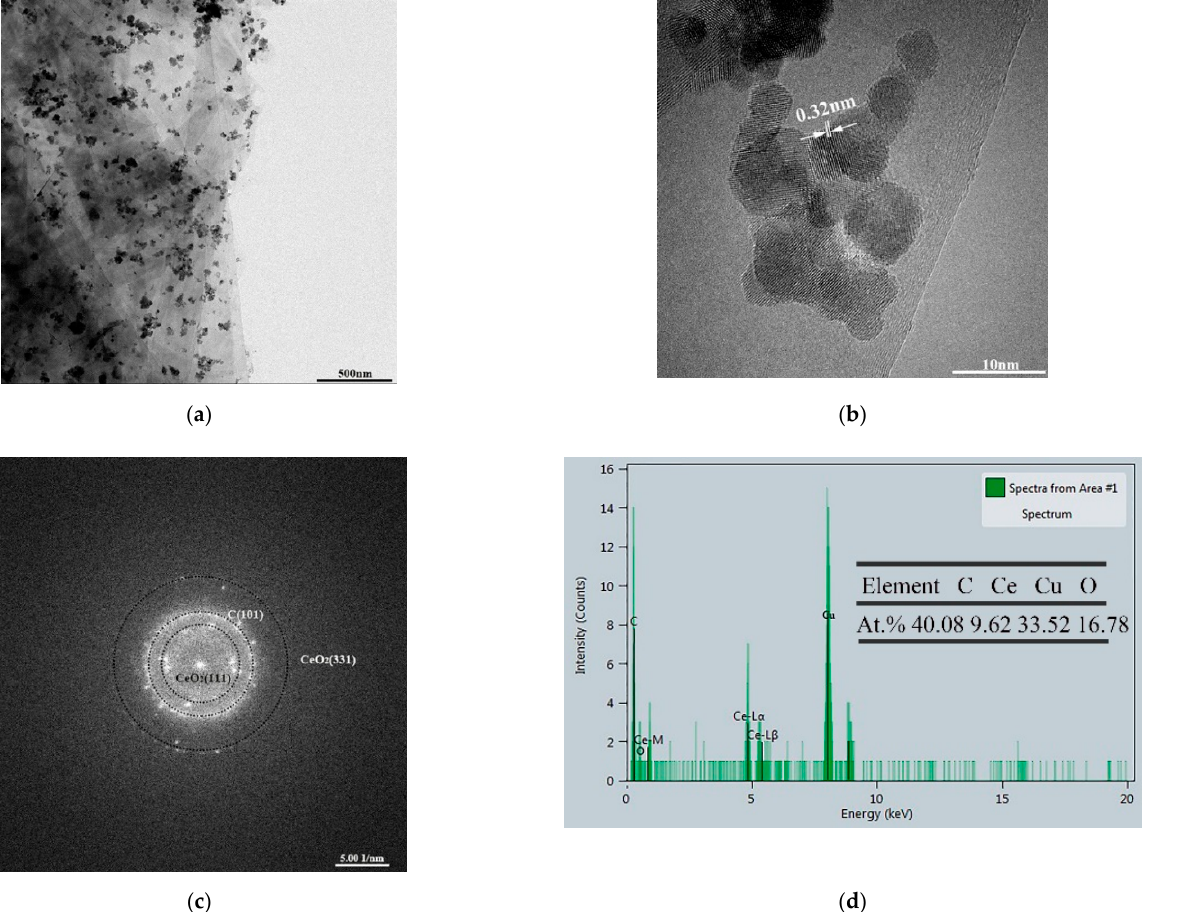
Figure 3. TEM photographs of CeO 2 -GNPs: ( a ) TEM and ( b ) HRTEM images of CeO 2 -GNPs; ( c ) SAED patterns; ( d ) cor- Figure 3. TEMphotographsofCeO 2 -GNPs: ( a )TEMand( b )HRTEMimagesofCeO 2 -GNPs; ( c )SAEDpatterns; ( d ) corresponding responding EDX result of the nanoparticles. EDX result of the